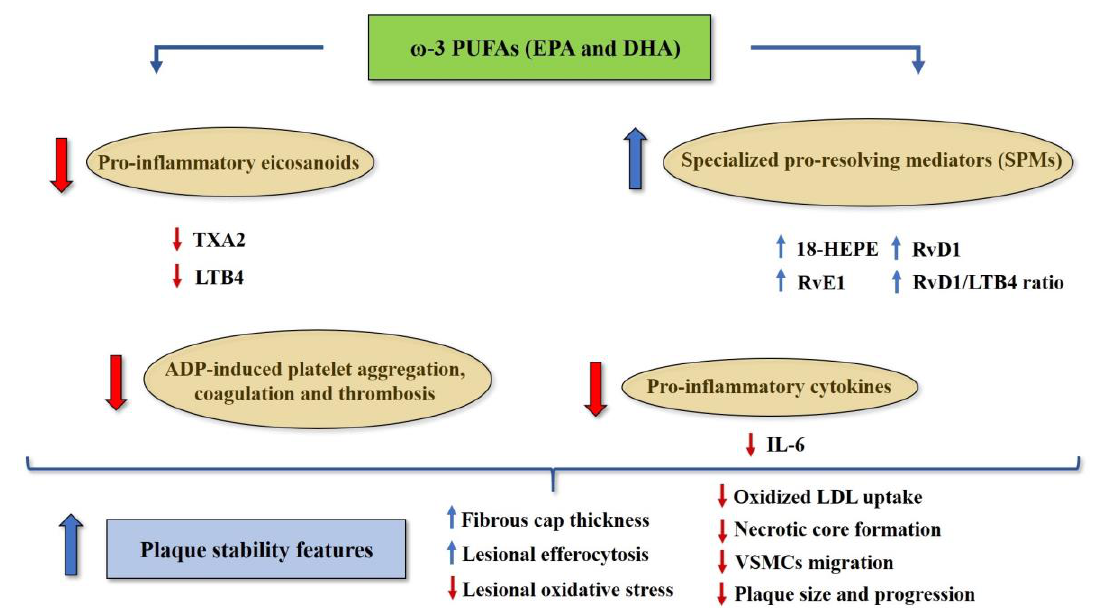
Figure 3. Potential mechanisms underlying the protective e ff ects of omega-3 PUFAs EPA and DHA against vascular inflammation and atherosclerosis. Abbreviations: 18-HEPE, 18-monohydroxy EPA; ADP, adenosine diphosphate; EPA, eicosapentaenoic acid; DHA, docosahexaenoic acid; IL-6, interleukin-6; LDL, low-density lipoprotein; LTB4, leukotriene B4; RvE1, resolvin E1; RvD1, resolvin D1; SPMs, specialized pro-resolving mediators; TXA2, thromboxane A2; VSMCs, vascular smooth muscle cells.